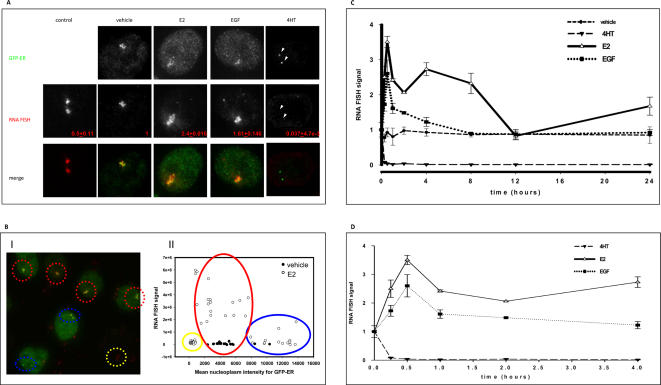
ER transcriptional activity at the promoter array.PRL-HeLa cells transiently expressing GFP-ER were treated with E2, EGF, 4-hydroxytamoxifen (4HT) or ethanolic vehicle for the indicated time. Subsequent to ligand treatment the cells were fixed and subjected to an RNA FISH protocol using a biotinylated dsRED2 probe followed by fluorescent-tagged streptavidin. A. Representative images of a single cell for each treatment. The presence of transcripts at the promoter array is identified by accumulated signal above the level for the nucleoplasm. The inset values (red type) represent the amount of transcript at 2 hours, relative to vehicle controls. B. Representative image of PRL-HeLa cells transfected with GFP-ER (green) exemplify the heterogeneity of ER expression levels. The cells show the RNA FISH signal associated with the array in the cell population (red signal) (I). The nuclear GFP-ER mean of fluorescence and RNA FISH array signal were plotted for vehicle- and E2-treated cells. Each symbol represents the measurements from a singe cell (II). C. To quantify FISH signal over 24 hours the total intensity of signal at the array (minus background signal) was determined by cumulative summation of 20 planes. Data represent the mean ±SEM of three different experiments graphed as fold induction over mean time-matched vehicle-treated control cells. D. This panel represents the earlier time points for E2 and EGF treatment. Fold activation between EGF and E2 at 30 minutes was significantly different, with a p value of 0.03.